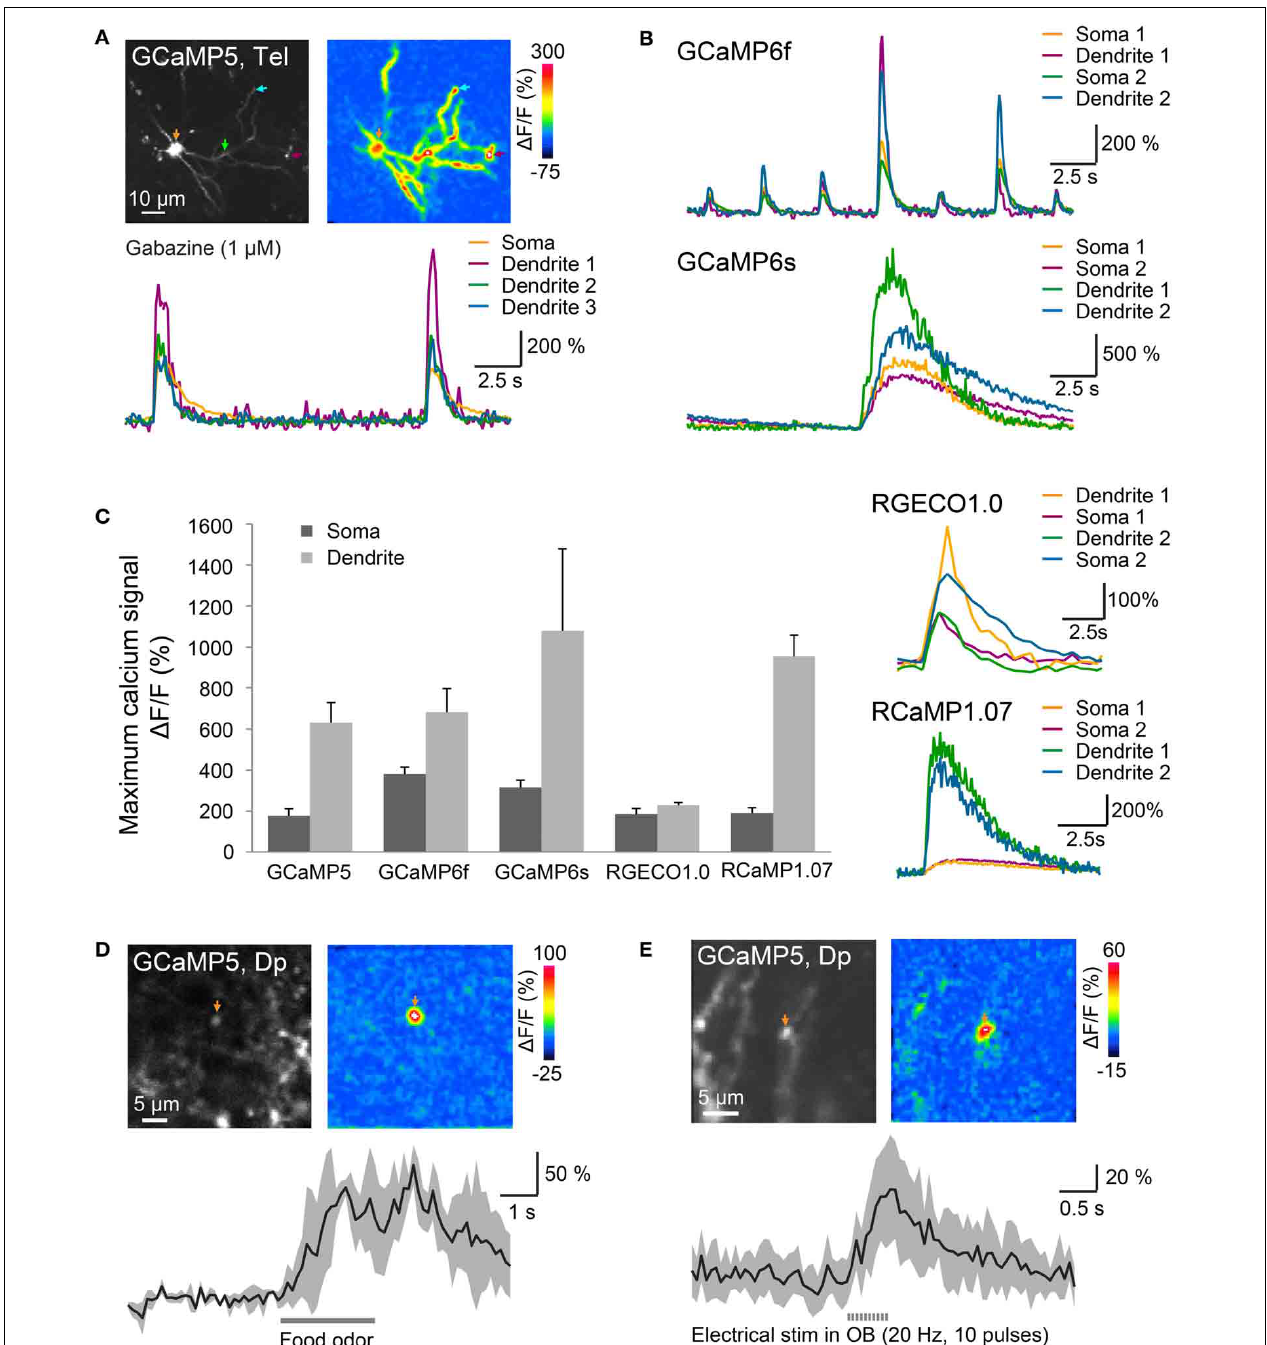
FIGURE 5 | Optical measurements of calcium signals after targeted electroporation of GECIs. (A) Top left: expression of GCaMP5 in a neuron of the dorsal telencephalon after EEP of plasmid #11. Bottom: change in GCaMP5 fluorescence as a function of time. Colored traces correspond to the locations indicated by colored arrows in the images above. Large, low-frequency calcium transients were induced by Gabazine (1 μ M), which causes epileptiform population activity. Top right: spatial distribution of fluorescence changes ( (cid:3) F/F) during a calcium transient, relative to baseline before the transient. (B) Calcium transients in the presence of Gabazine